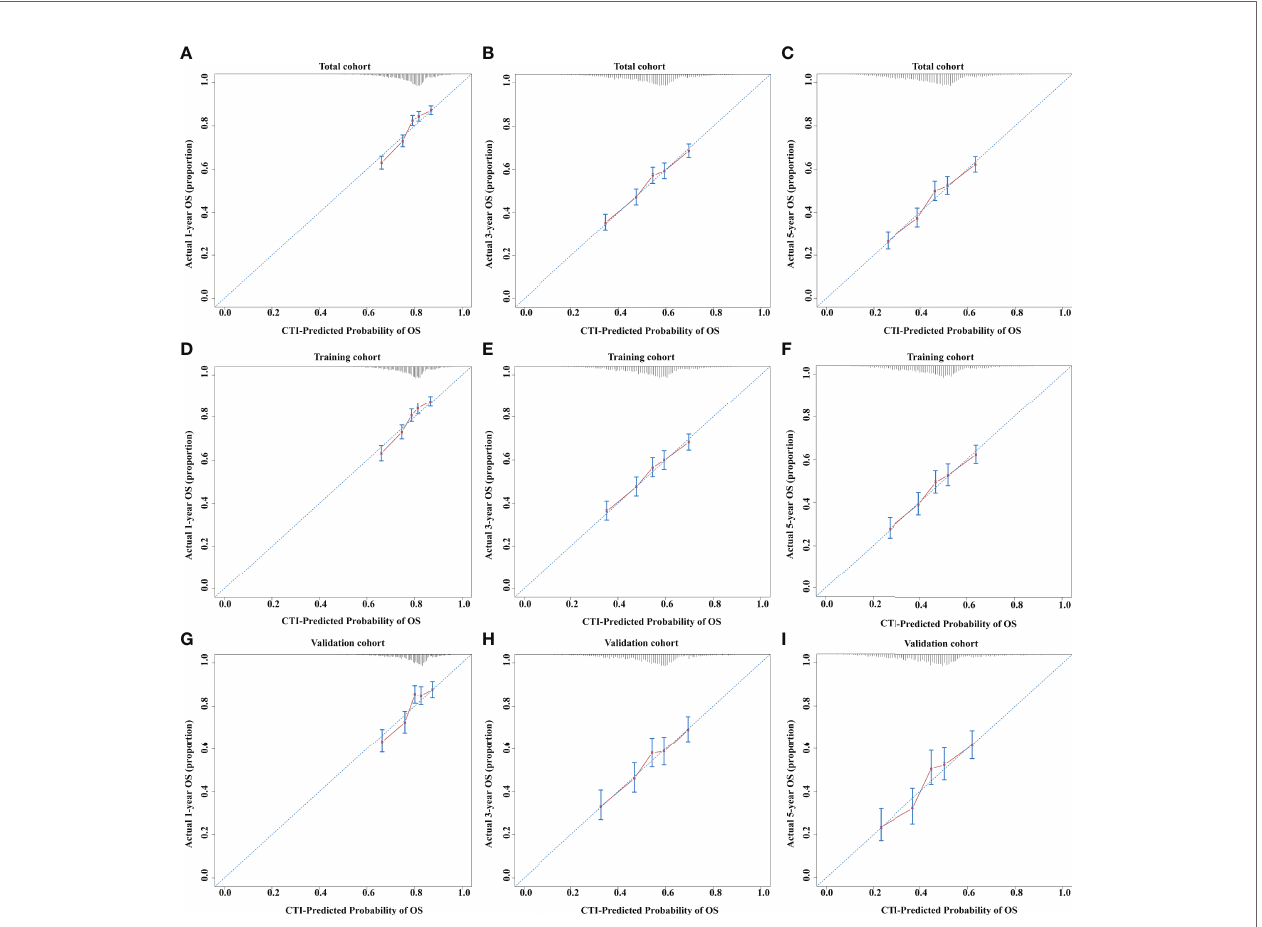
FIGURE 3 | The 1-, 3-, and 5-year calibration curves of CTI in the different cohorts of patients with cancer. (A – C) 1-, 3-, and 5-year calibration curves of CTI in total cohort. (D – F) 1-, 3-, and 5-year calibration curves of CTI in training cohort. (G – ) 1-, 3-, and 5-year calibration curves of CTI in validation cohort. CTI, C-reactive protein-triglyceride glucose